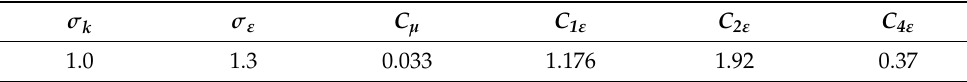
Table 2. Turbulence model